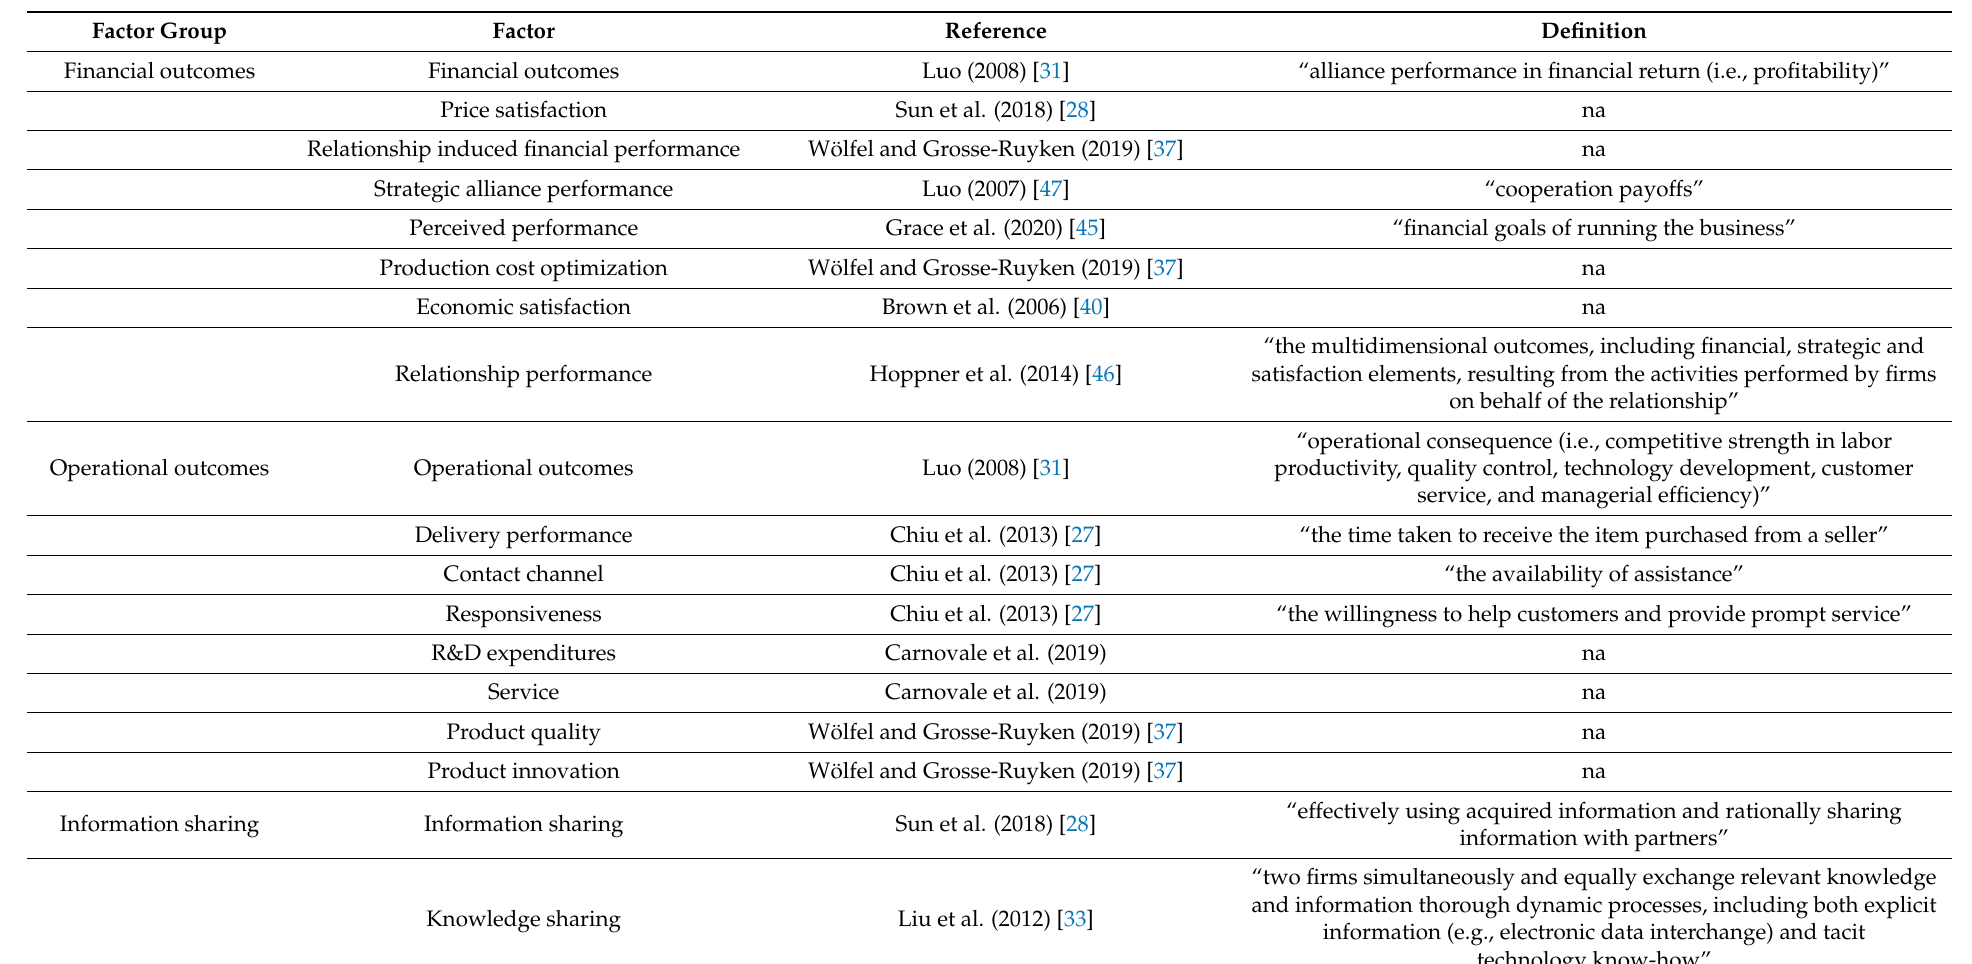
Table 1. The factors (e.g., antecedents and consequences) comprising the factor